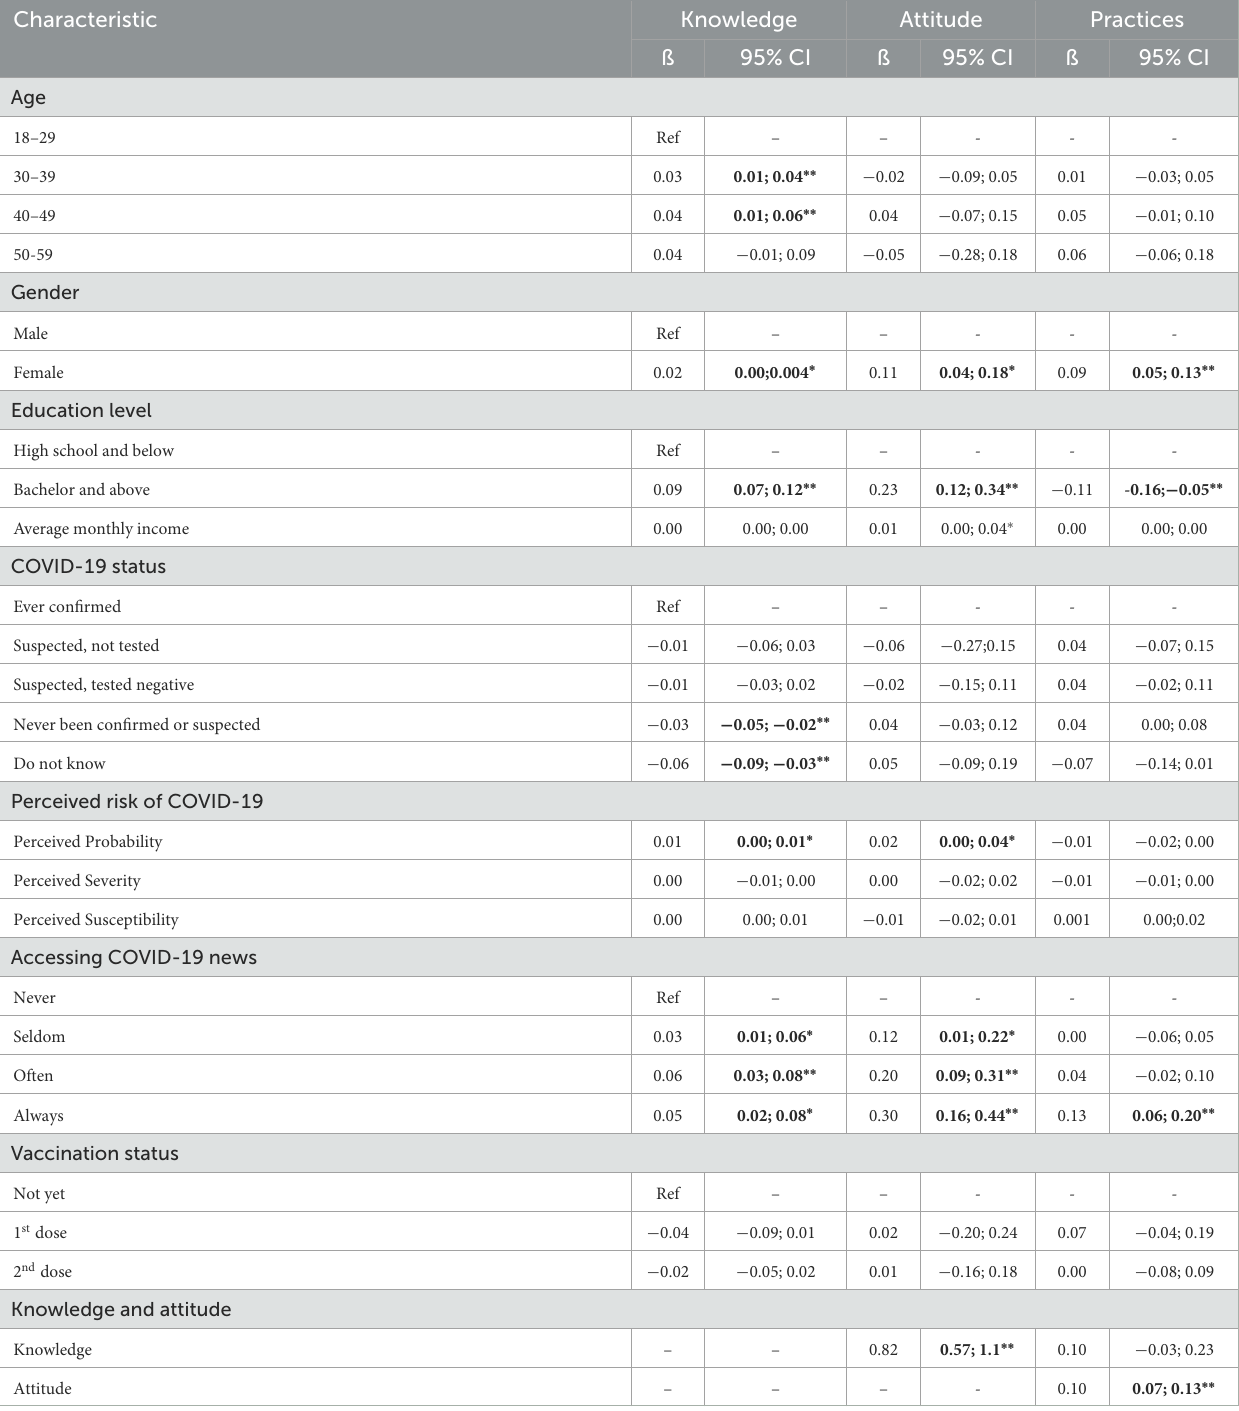
TABLE 5 Factors affected the knowledge, attitude, and practices related to the post-COVID-19 delta wave situation in Indonesia. Characteristic Knowledge